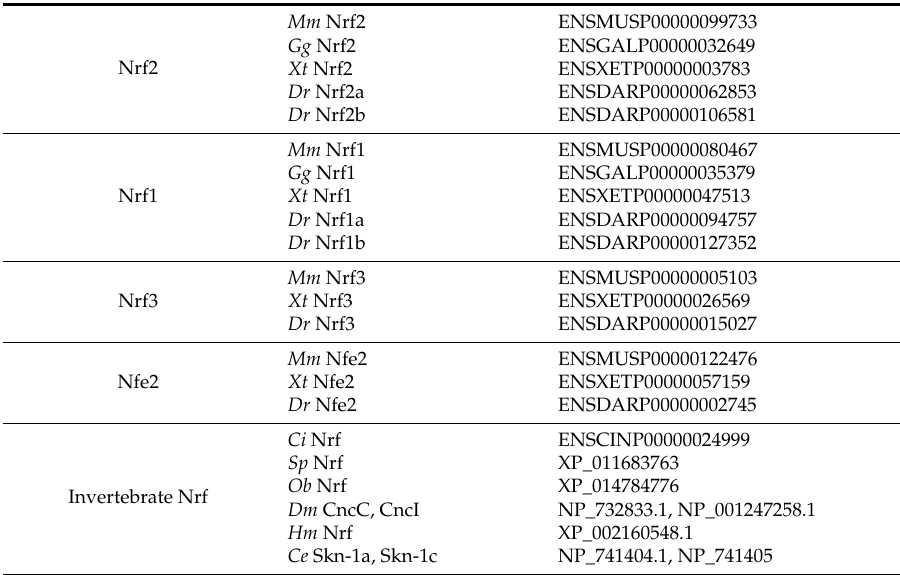
Table 1. Summary of Nrf